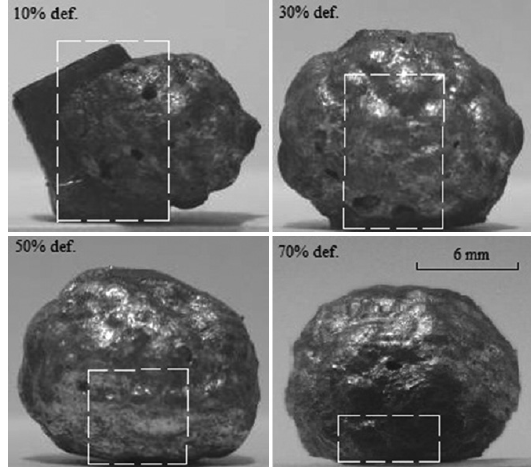
Figure 7. The appearance of the samples foamed for 3.5 min after being deformed at various rates.